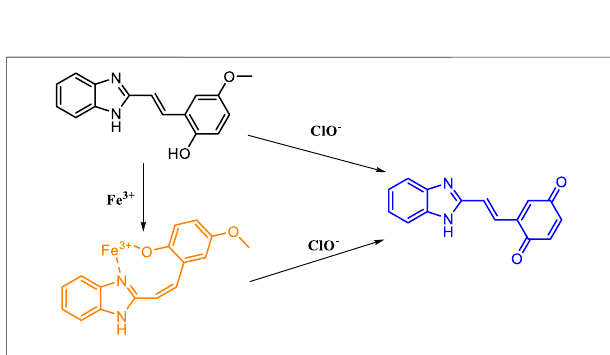
SCHEME 2 | Molecular structure of MBI-OMe and the proposed sensing